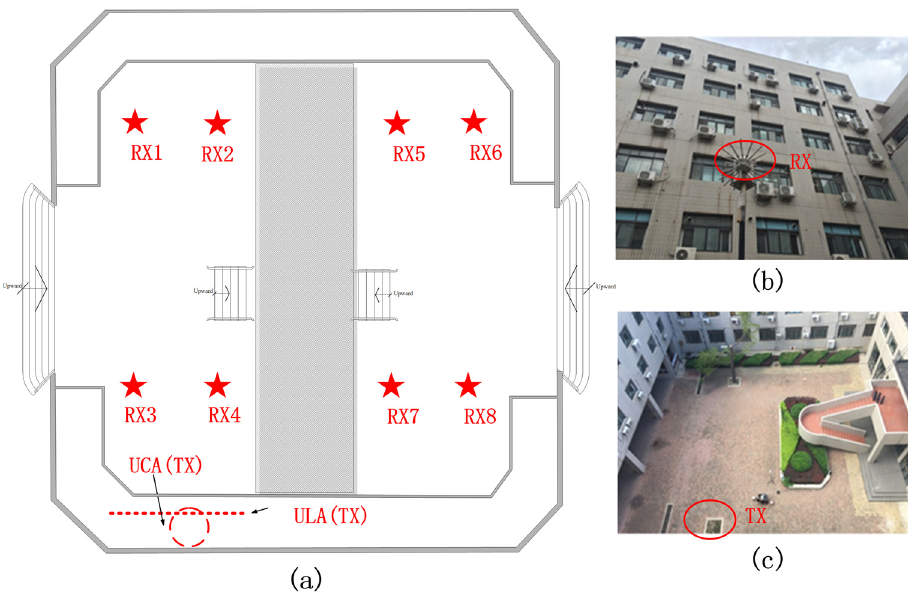
Figure 1. Massive MIMO channel measurement system. ( a ) The measurement scenario sketch map; ( b ) sight from the receiver in-field; ( c ) sight from the transmitter